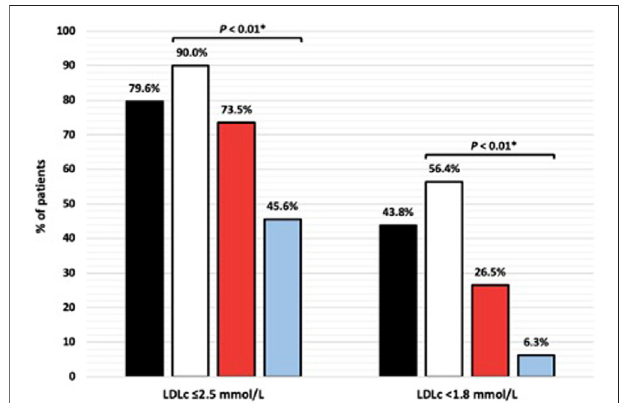
FIGURE 1 | Attainment of LDL cholesterol (LDLc) targets by adherence. Blackbars,totalpopulation;whitebars,adherent;redbars,nonadherent;blue bars, no statin. * p < 0.05 indicates signi fi cant differences between adherent, nonadherent and non-statin